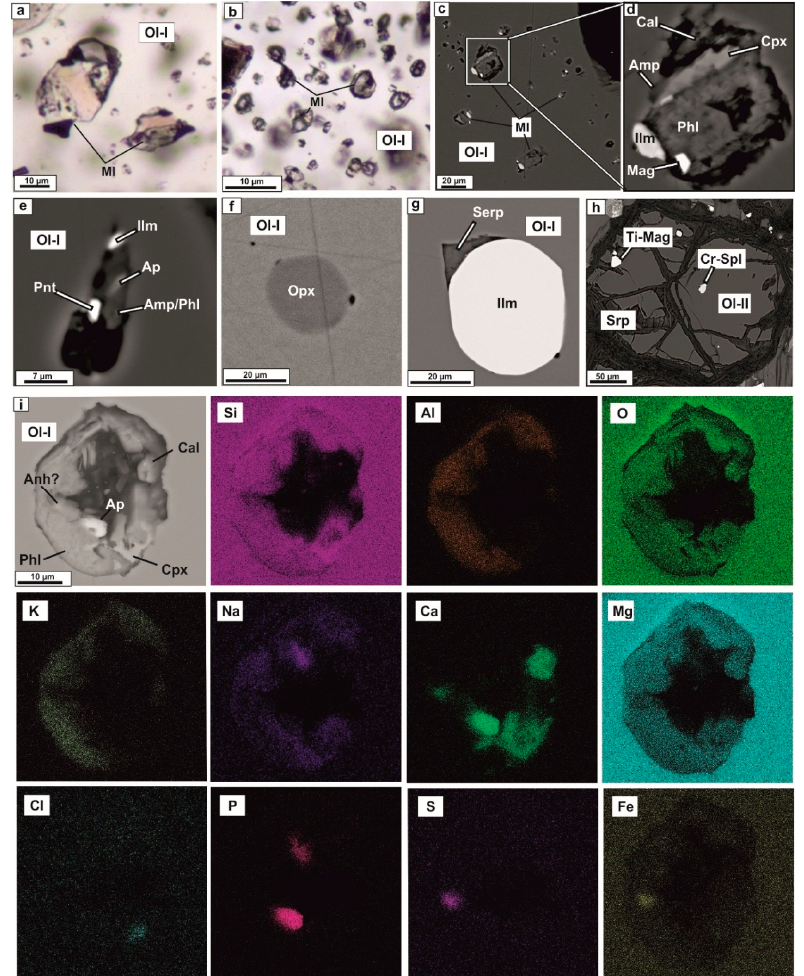
Figure 9. Melt inclusions (MI) in the olivine macrocrysts (Ol-I) and phenocrysts (Ol-II) of the aillikites of the Terina complex: ( a,b ) photomicrographs of the secondary melt inclusions under the optical microscope; ( c–e ) BSE photos of the opened melt inclusions which are composed of ilmenite (Ilm), magnetite (Mag), amphibole (Amp), calcite (Cal), clinopyroxene (Cpx), phlogopite (Phl), and apatite (Ap) daughter-phases and the xenogenic pentlandite (Pnt) crystal phase; ( f ) BSE-photo of the orthopyroxene (Opx) and ( g ) ilmenite mineral inclusions with serpentine (Serp) in the olivine macrocrysts; ( h ) spinel-group (Cr-Spl) and Ti-magnetite (Ti-Mag) mineral inclusions in the olivine phenocryst (Ol-II); and, ( i ) BSE-photo and electron microprobe (EMP) X-ray element maps showing the chemical composition of the opened melt inclusion in olivine-I: calcite (Cal), apatite, clinopyroxene, phlogopite, and probably anhydrite (Anh) are present as daughter phases.